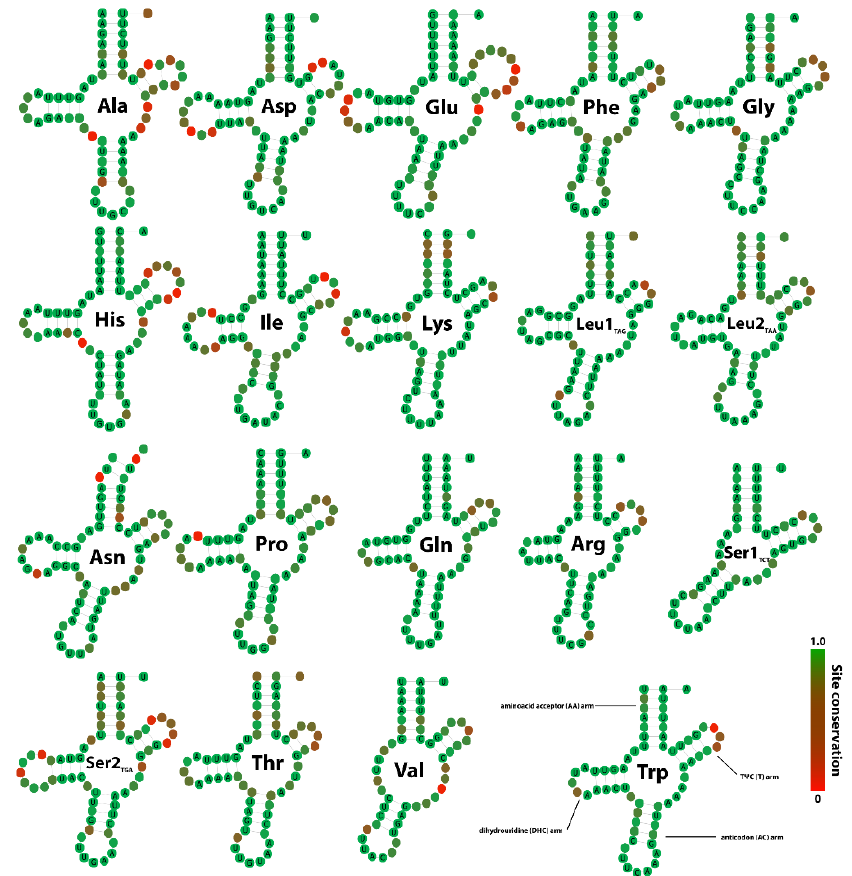
Figure 4. Mitochondrial tRNAs structures. Secondary structures predicted for the 19 studied Table 0. means Scheme 539. and 738 changes were found in stems and loops, respectively (Table S6). Some tRNAs’ stems showed a higher number of substitutions (e.g., S2 51, F 48, and T 41 and A 40) whereas others exhibited values lower than average (e.g., E 16, R 16, L1 17 and S1 17). Stems included some indels (13) since analyses are based on comparisons to a single secondary structure (majority-rule consensus) per alignment and D- and T-stem sequences were different in length. The analysis in loops reconstructed more nucleotide substitutions and indels (96) than those found in stems with some tRNAs displaying more changes (S2 59, H 58, E 57 and V 54) than others (K 17, L2 23, R 27 and W 27). The most frequent substitutions were transitions A -> G, T -> C, G -> A and C -> T in stems and loops but the latter also showed high frequencies A -> T, T -> A, T -> C and C -> T (Table S6).